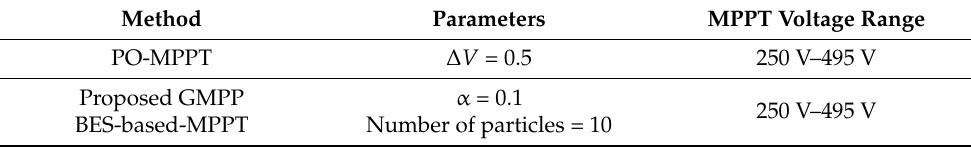
Figure 5. Curves of the actual insolation and ambient temperature for a cloudy day. Table 2. Parameters of the PO-MPPT and the proposed BES-MPPT. Method